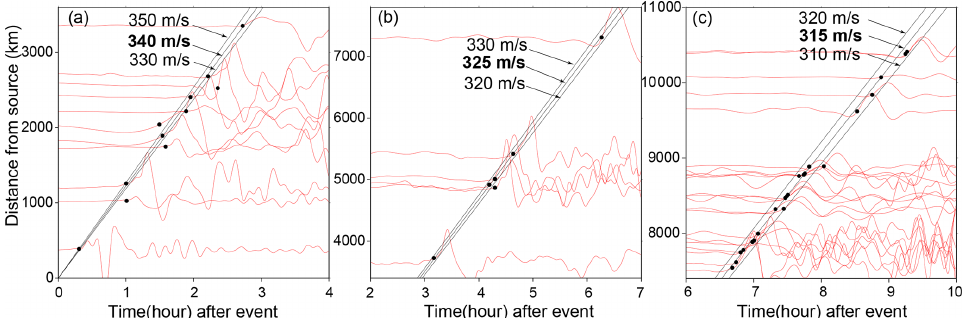
Figure 3. Identifying the Lamb-wave-induced tsunami velocities using different constant velocities as constraints. Black dots mark the arrival times of the Lamb waves. Black lines represent different velocities.